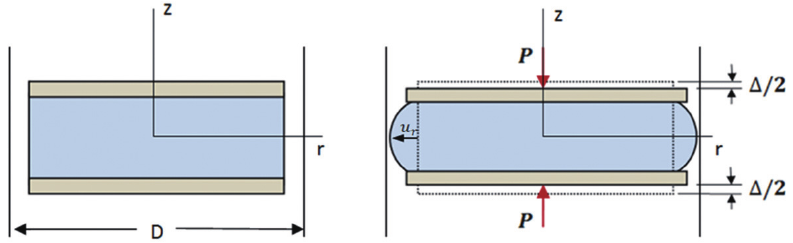
Fig. 3. Undeformed and deformed con fi gurations of a bonded elastic